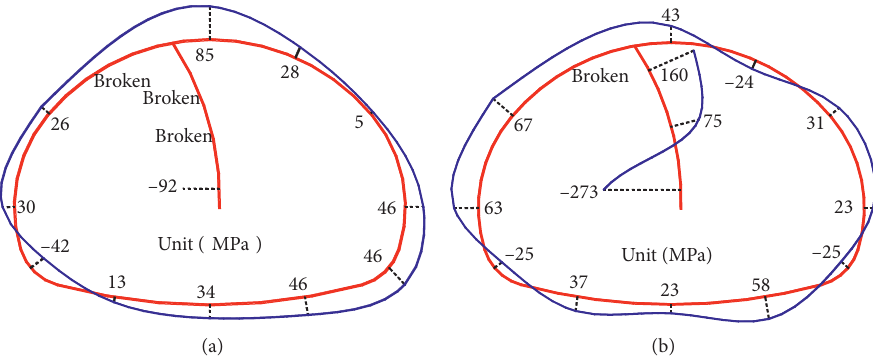
Figure 13: Stress distribution of steel rib in YK2+133 section. (a) Maximum value of outside steel rib. (b) Stability value of inside of stress rib.